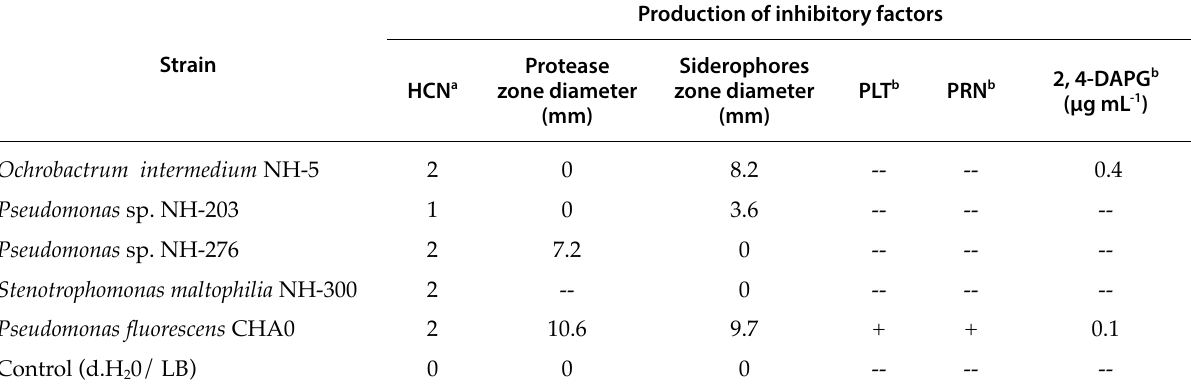
Table 3. Production of different antifungal metabolites by antagonistic